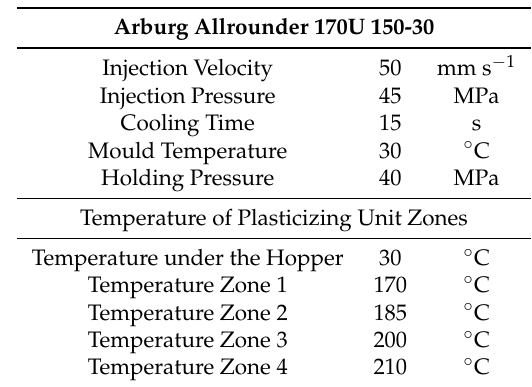
Table 2. Injection moulding parameters.